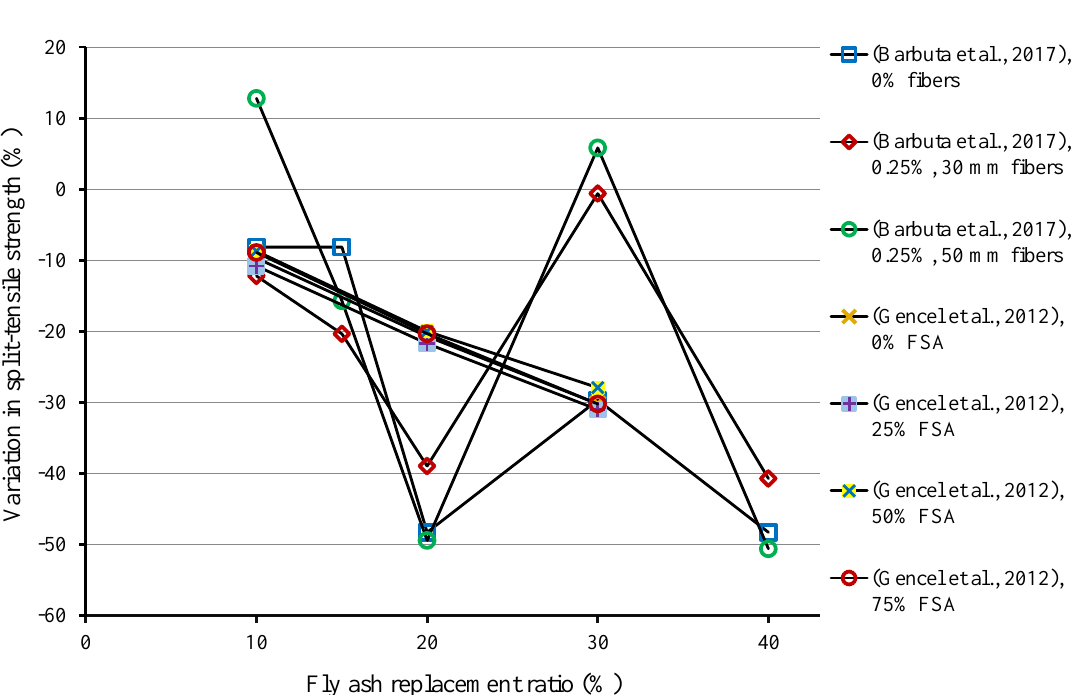
Figure 3. Influence of fly ash as cement replacement on 28-days split-tensile strength of composites. FSA: ferrochromium slag aggregate [107,108].